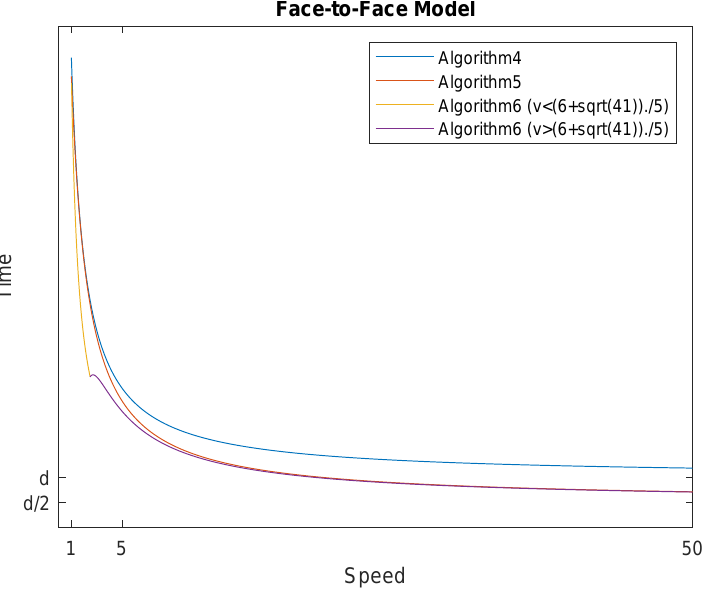
Figure 2. Graph for the three algorithms using the face-to-face model. On high speed, the evacuation time for Algorithm 7 converges to d . The same is for Algorithm 6 versus d for Algorithm 2